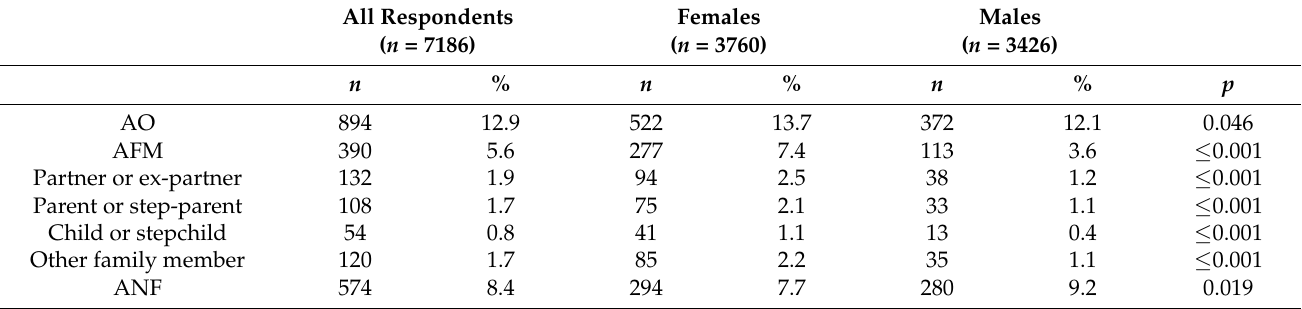
Table 1. The proportion of affected others (AOs) in 2016 and the problem gambler’s relationship to the AO by gender. All